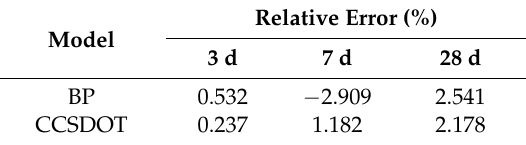
Table 7. Comparison between the predicted results of BP neural network and CCSDOT